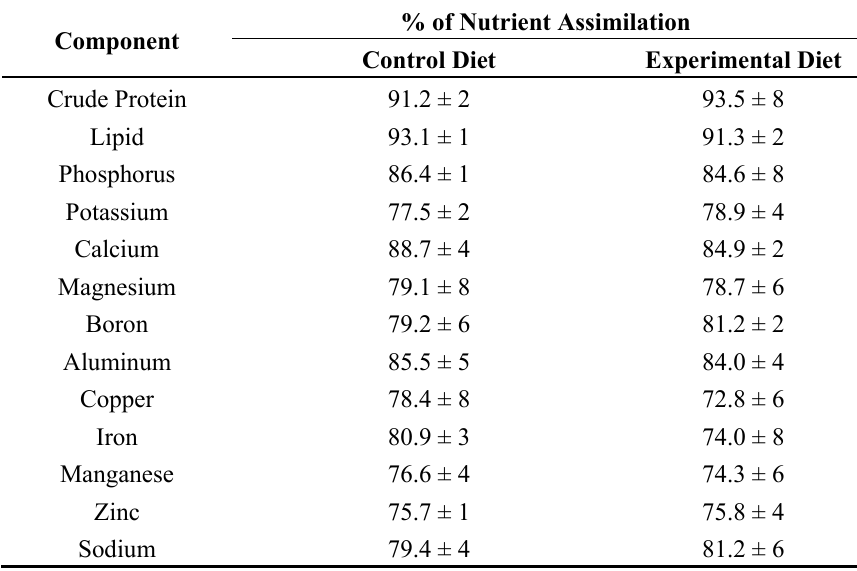
Table 5. Nutrient assimilation efficiency in control and experimental diets fed to